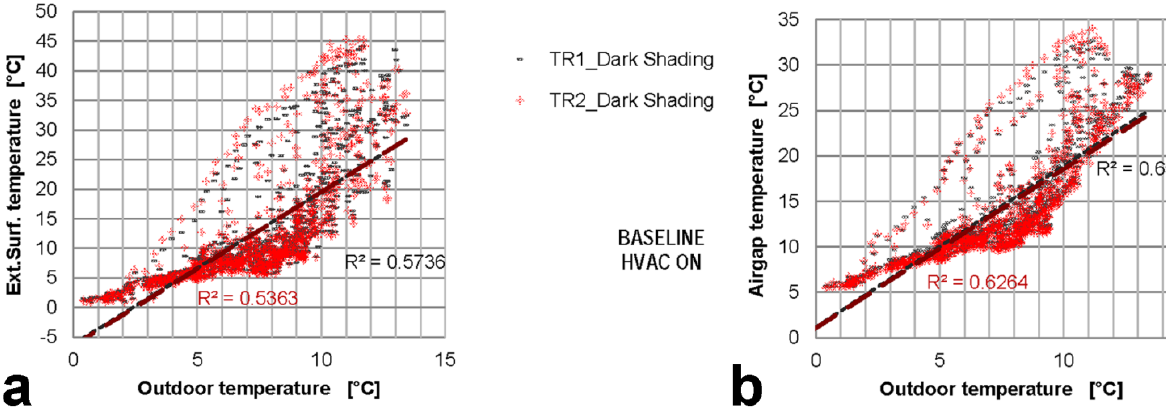
Figure 4. Shutter external surface temperature ( a ) and airgap temperature ( b ) of the two test-rooms vs. outdoor thermal conditions in baseline